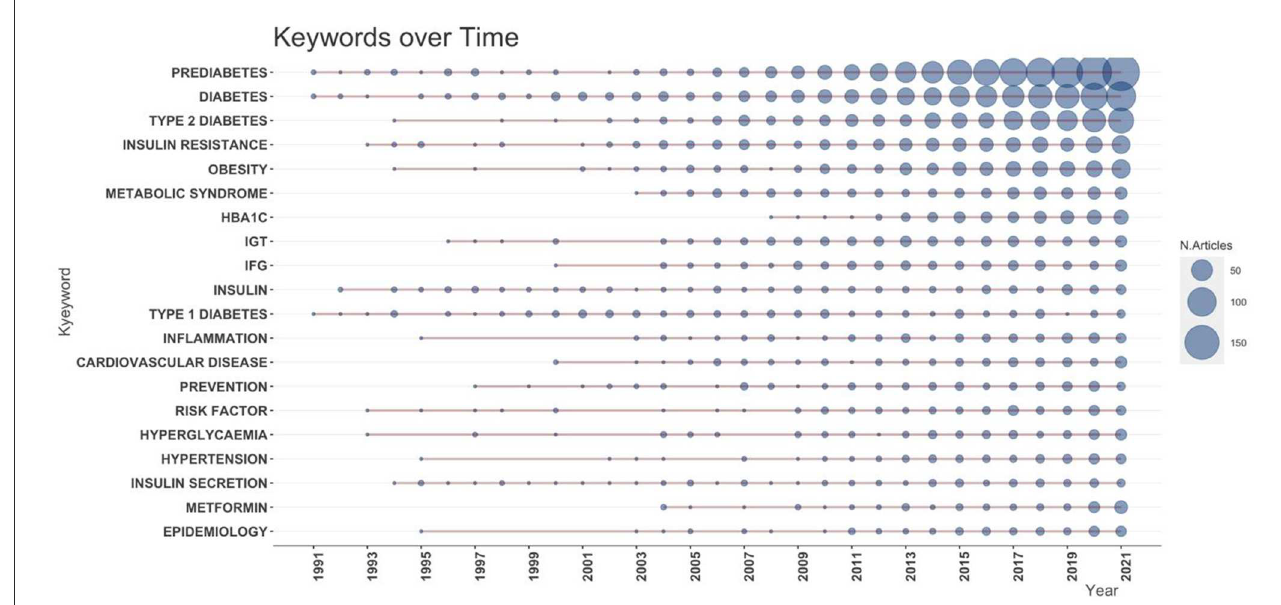
FIGURE6 Production of the top 20 keywords over time.